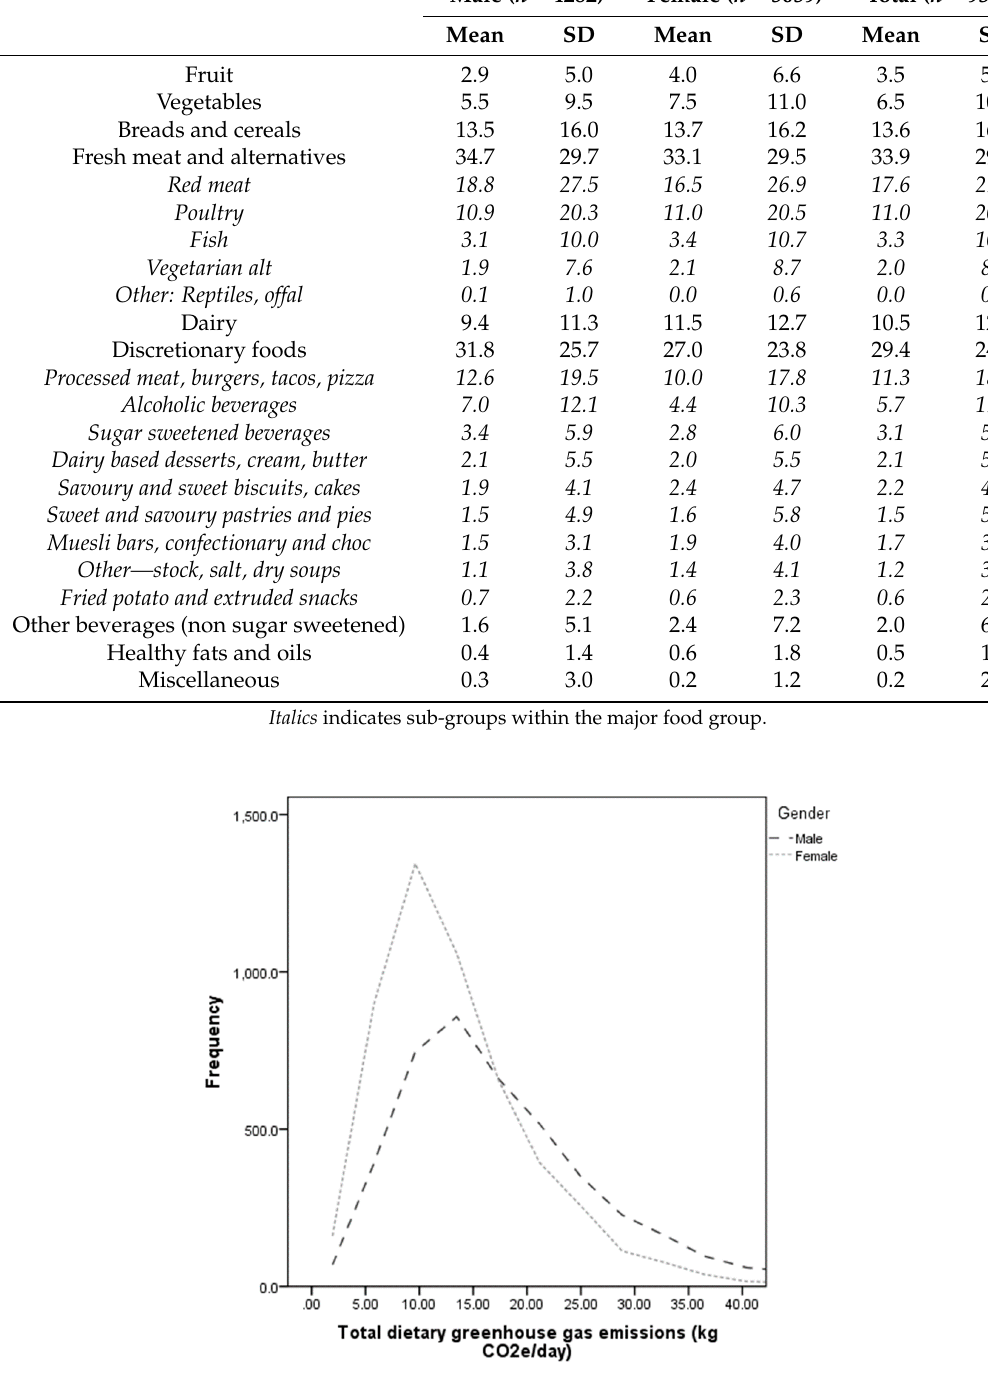
Figure 2. Scatterplot of total dietary greenhouse gas emissions against total energy intake for Australian males ( n = 4282) (black) and Australian females (grey n = 5059).